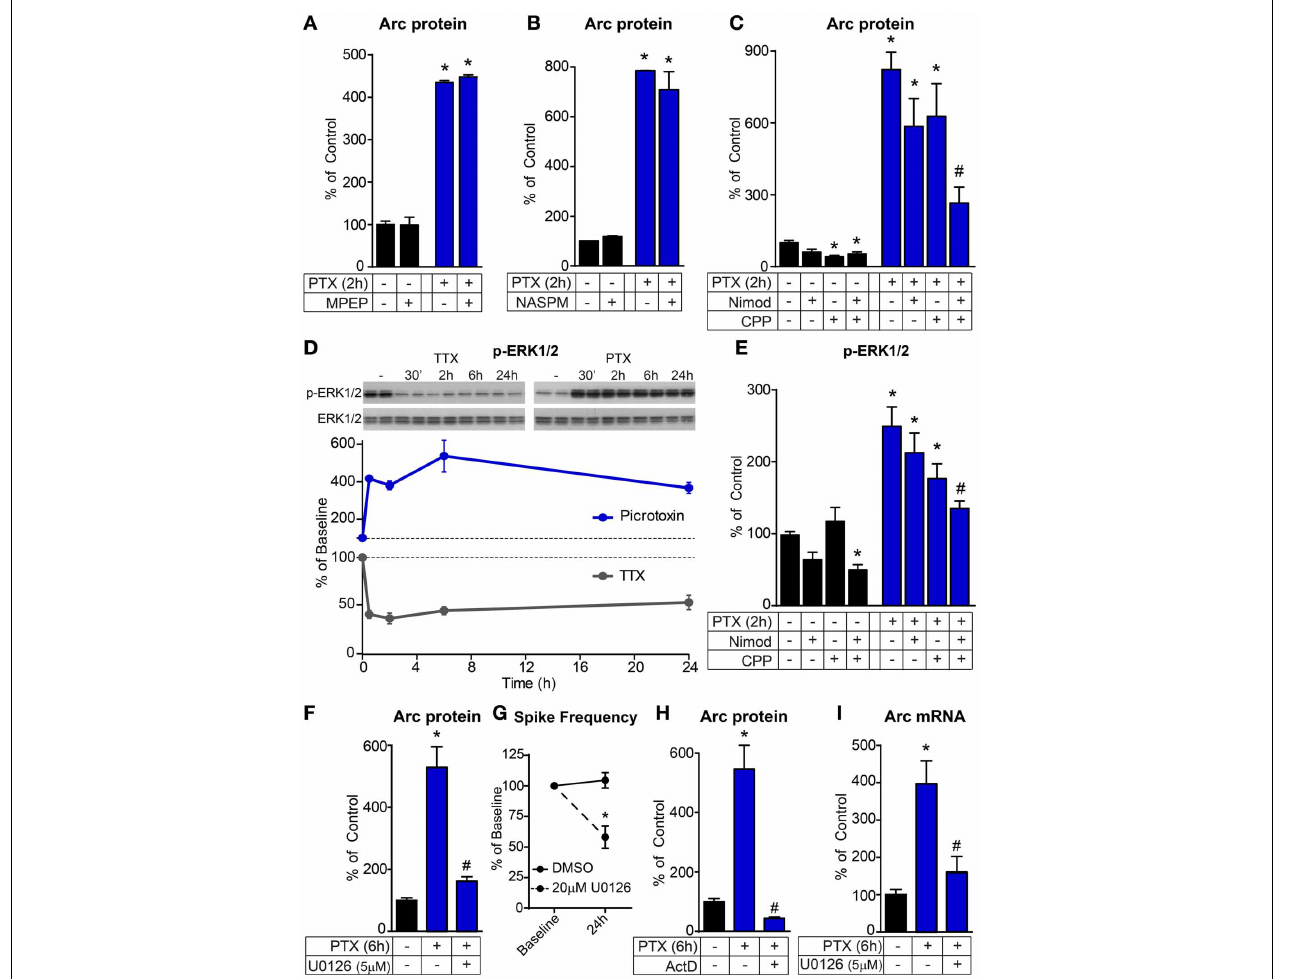
FIGURE 3 | The activity-dependent induction of Arc requires ERK1/2-dependent transcription. (A–C) Bar graphs displaying western blot data of Arc protein normalized to GAPDH loading control. Hippocampal cultures were treated for 2h with 50 μ M picrotoxin (PTX) and pre-incubated for 30min with either 4 μ M MPEP (A) , 10 μ M NASPM (B) , 5 μ M nimodipine (Nimod) and/or 10 μ M CPP (C) . (D) Top: representative western blots of phosphorylated ERK1/2 (p-ERK1/2, Thr202/Tyr204) normalized to total ERK1/2 protein following treatment with TTX (left) or picrotoxin (PTX, right) for the indicated times in hours. Bottom: average p-ERK1/2 levels in neurons treated with picrotoxin (blue) or TTX (gray) for the indicated times. Dotted lines at 100% indicate baseline levels. (E) Western blot data of p-ERK1/2 normalized